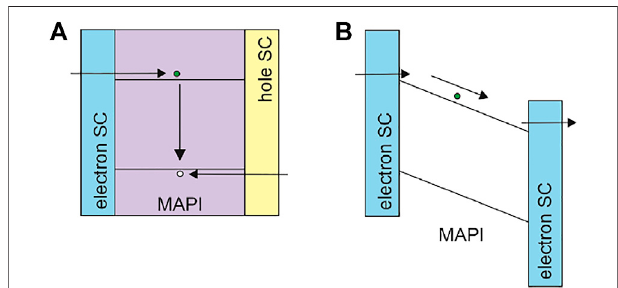
FIGURE 17 | Scheme of electrical current under strong injection regime. (A) In perfect selective contacts the current is completely due to recombination. (B) For similar contacts the device becomes a single carrier in which the current goes through from one contact to the other.